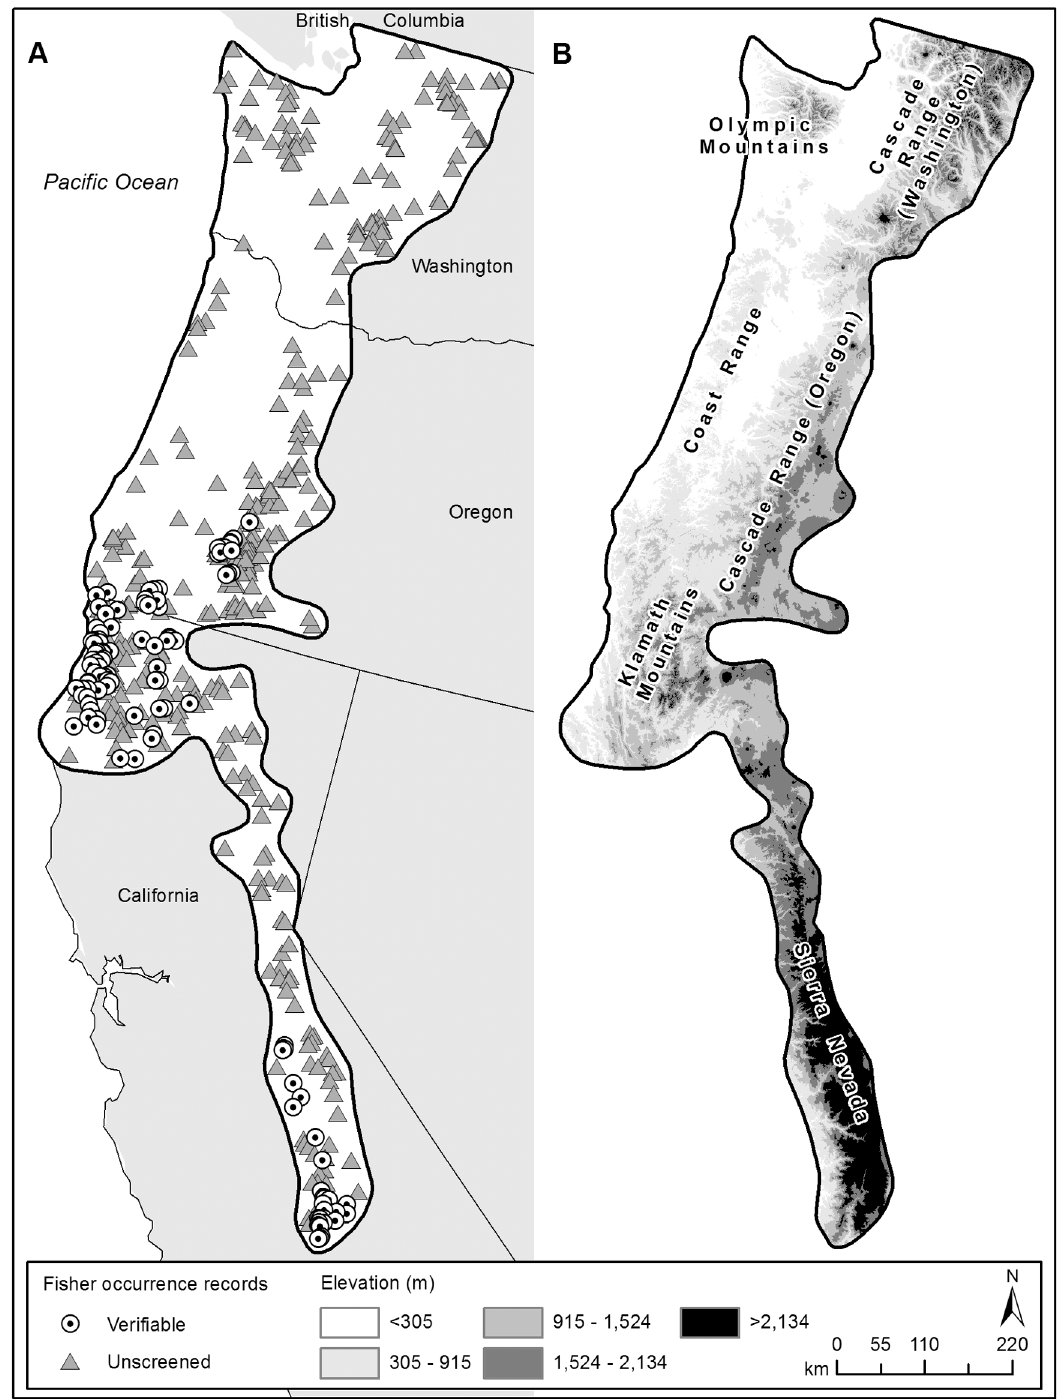
Fig 1. Maps depicting (A) the geographic extent of our analysis area in the Pacific States and the locations of verifiable and unscreenedfisher occurrence records used in Maxent modeling, and (B) the elevational gradient and major physiographic regions that occur within our analysis